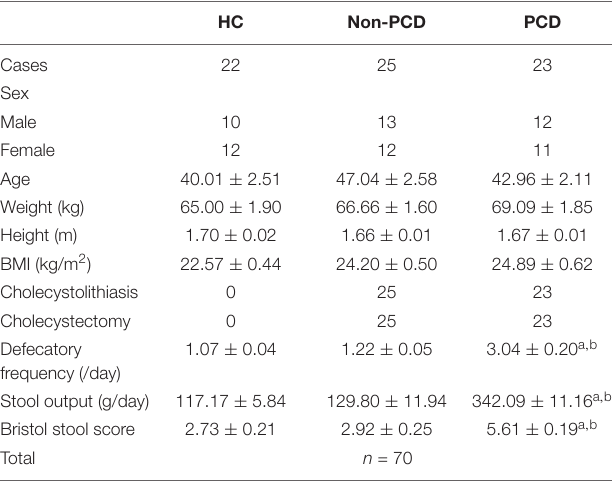
TABLE 1 | Demographic information of healthy controls and non-diarrheal and diarrheal patients after cholecystectomy in this